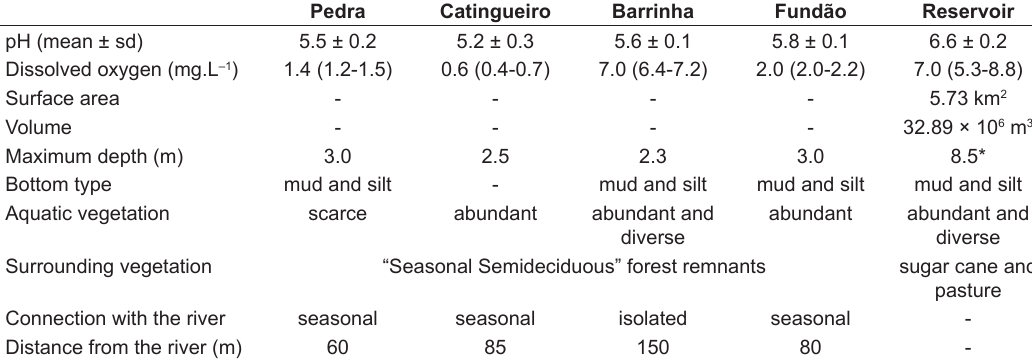
Table 1. Characteristics of the sampled sites (Catingueiro, Barrinha, Pedra and Fundão oxbow lakes, and reservoir) at Mogi Guaçu River, southeast Brazil. Adapted from Gonçalves and Braga (2008). Pedra Catingueiro